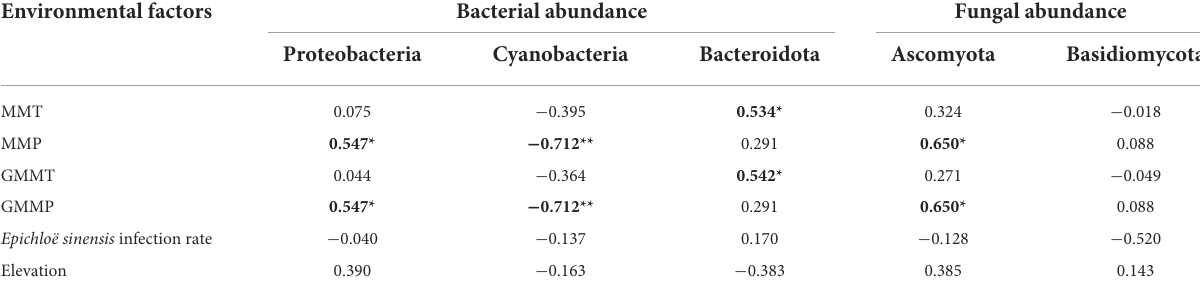
TABLE 4 Correlation coefficient between the relative abundance of the most abundance bacteria and fungi and environmental factors. Environmental factors Bacterial abundance Fungal abundance Proteobacteria Cyanobacteria Bacteroidota Ascomyota